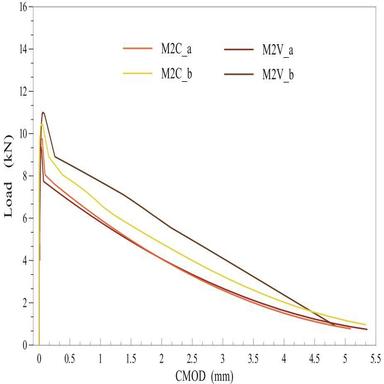
Mortar M2: Load – CMOD curves.